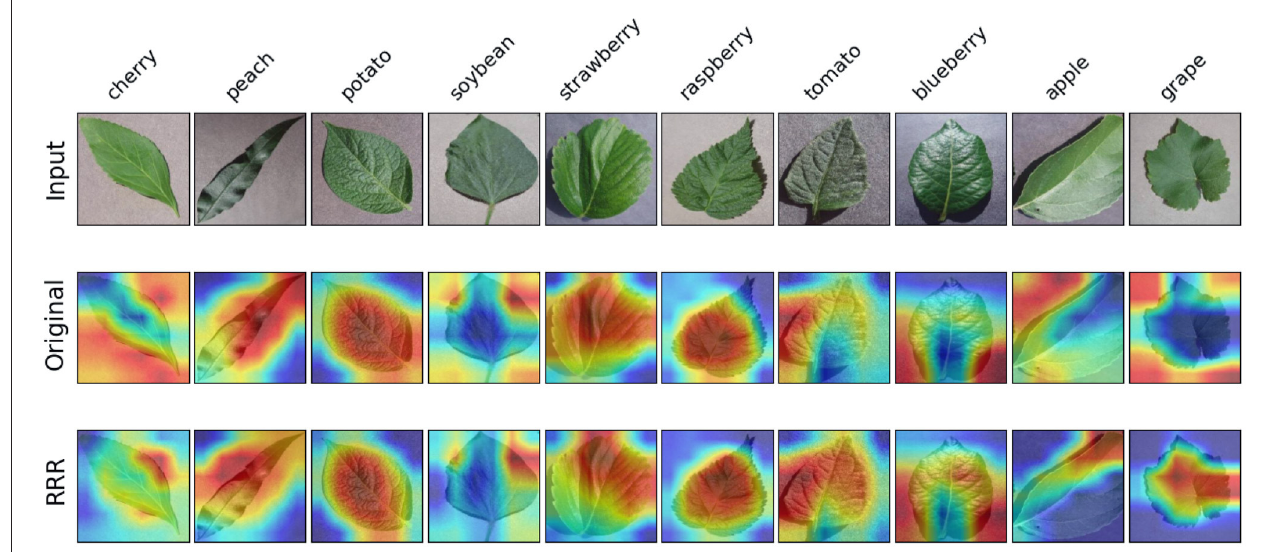
FIGURE 9 | Examples of model explanations for the third task. The 10 columns reflect the explanations of 10 species’ leaves. The three rows display the input image, original explanation, and the explanation with the consideration of expertise. A warmer color in the explanation indicates a higher contribution value, denoting a more important pixel for the classification task.